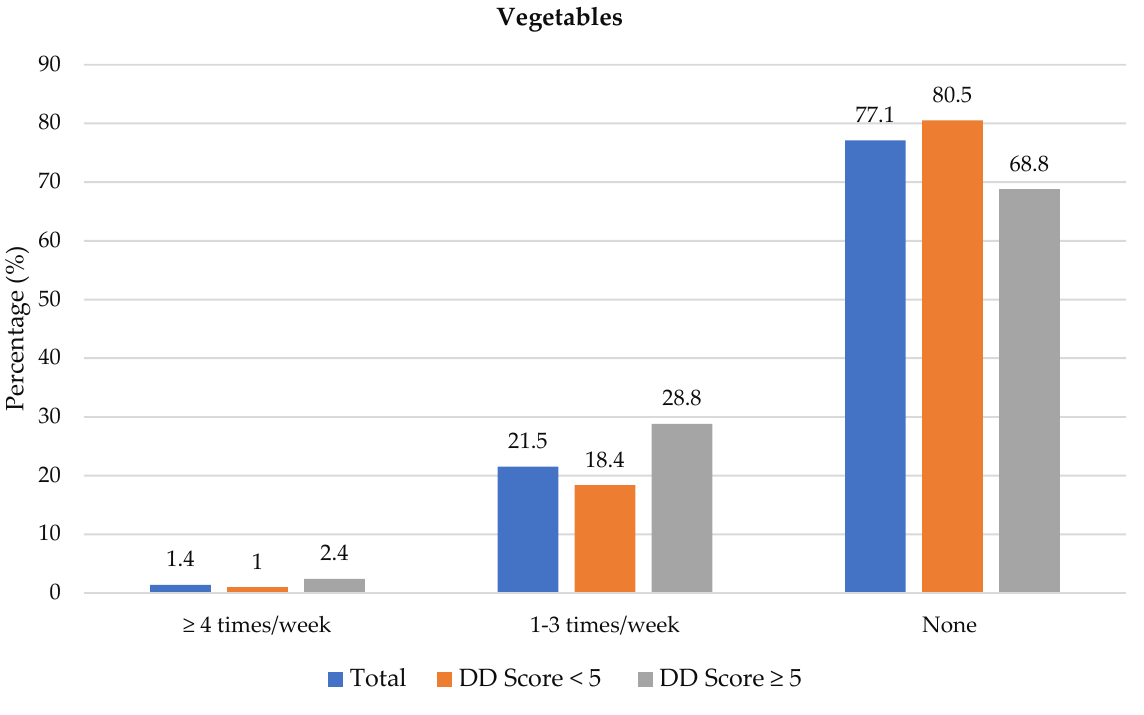
Figure 4. Frequency intake of fruit juice, fresh fruit and vegetables by dietary diversity (DD) score categories. * Significant difference between DD score categories at p < 0.05 level.